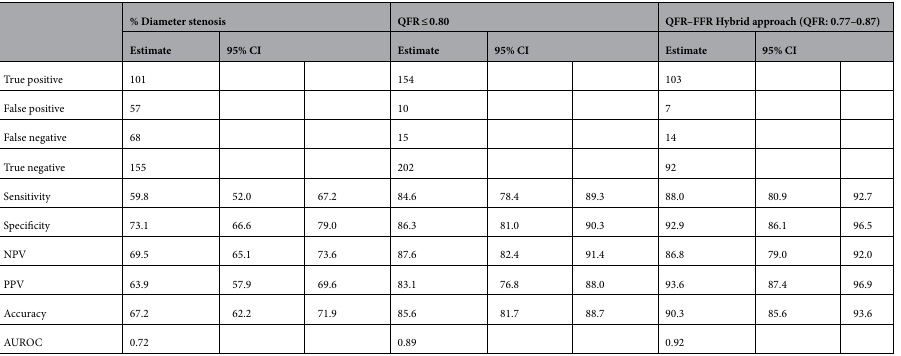
Table 2. Diagnostic test results quantitative flow ratio (QFR). The diagnostic performance of ICA based on diameter stenosis and QFR with fractional flow reserve (FFR) as reference standard. Both, FFR ≤ 0.80, diameter stenosis ≥ 50% QFR ≤ 0.80 and FFR ≤ 0.80—intermediate zone QFR (0.77–0.87) are used as diagnostic cut-off values. 95% CI 95% confidence interval, AUROC area under the receiver operator characteristic curve, NPV negative predictive value, PPV positive predictive